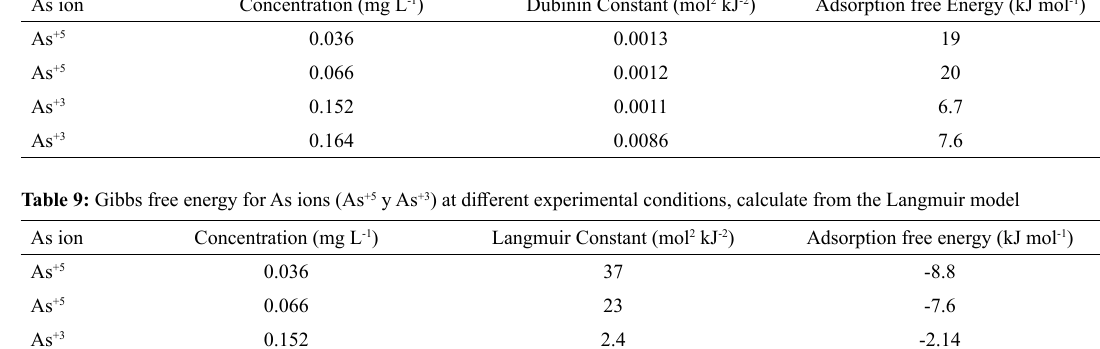
Table 8: Adsorption free energy for As ions (As +5 y As +3 ) at different experimental conditions, calculate from the Dubinin model As ion